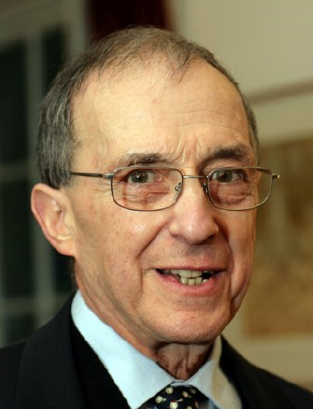
(Figure 2). Both missed a big birthday: Peter his 90th and Bob his 70th.